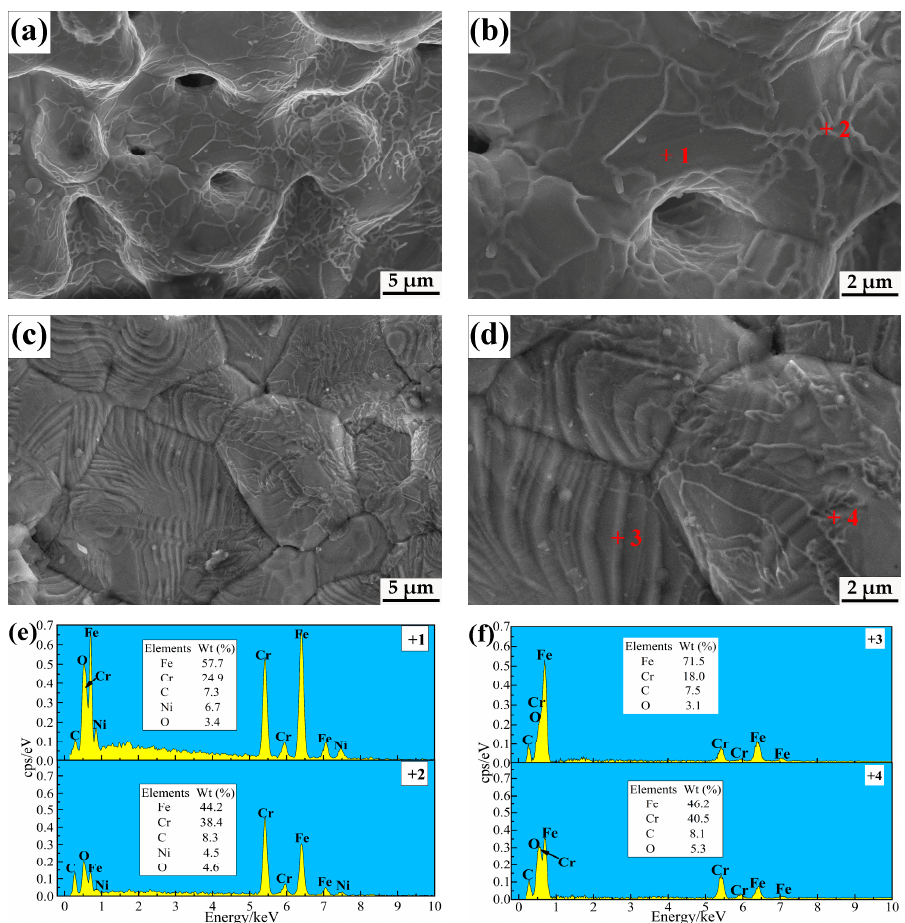
Figure 4. SEM images and EDS spectrum of the cell wall of the SSFs. ( a , b ) the SEM images of 304 SSFs; ( c , d ) the SEM images of 430 SSFs; ( e , f ) the EDS analysis map of 304 and 430 SSFs, respectively.